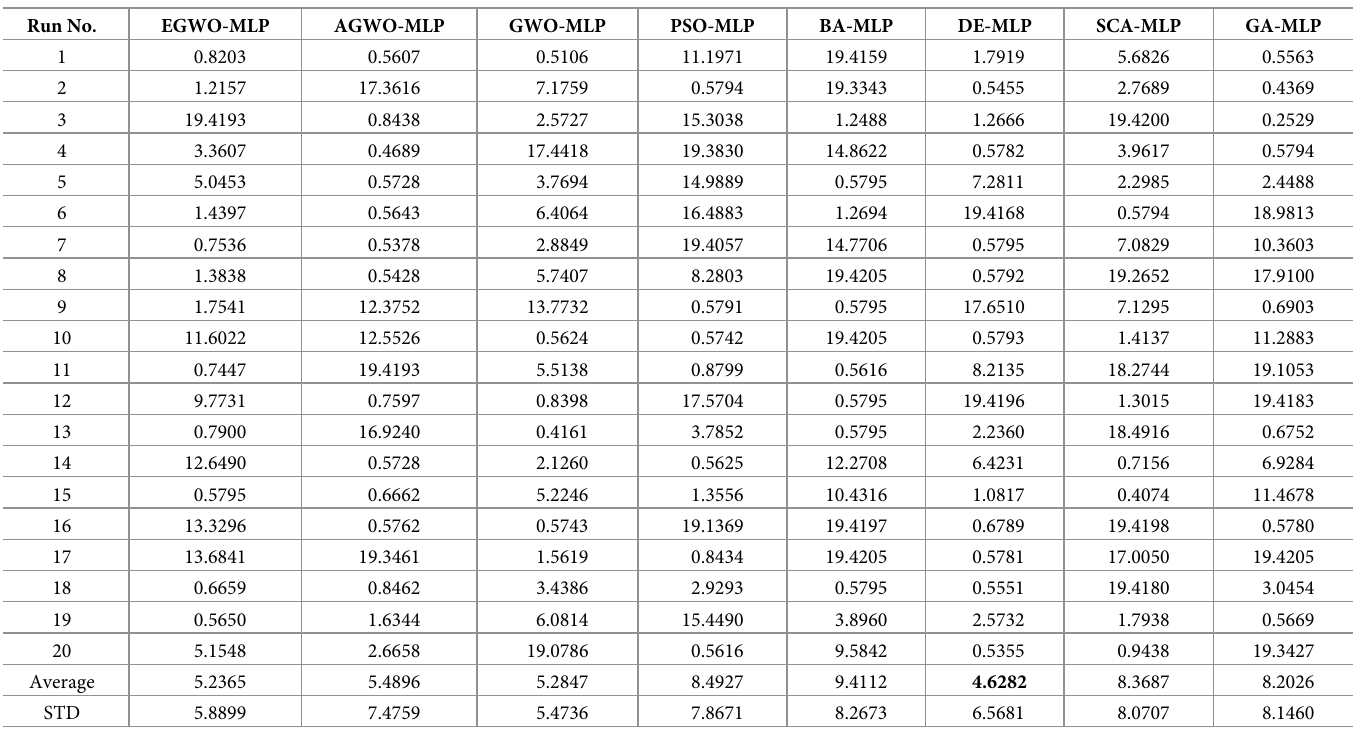
Table 4. The test error of the Mathematics (Mat.) subject achievement prediction.